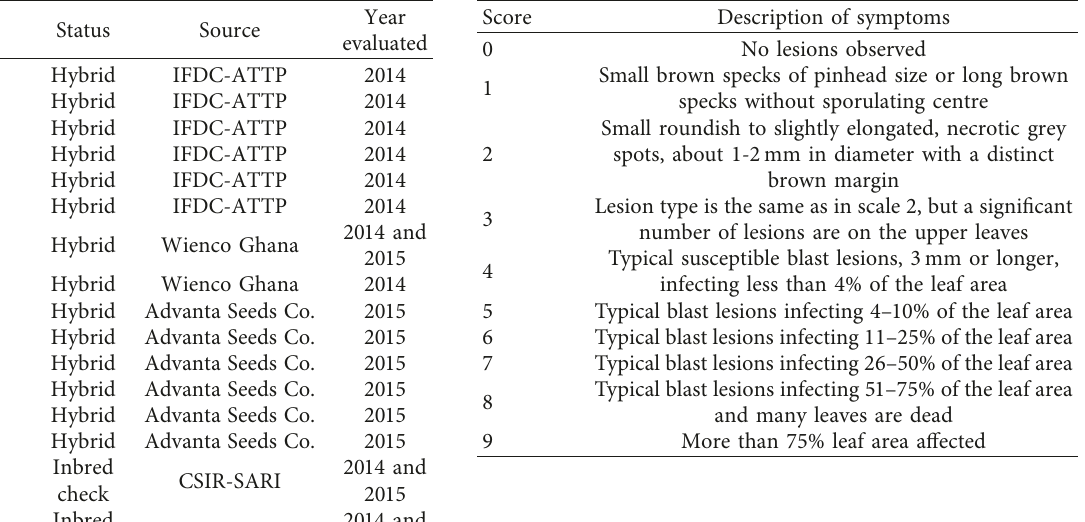
Table 3: Descriptive key for recording BLB severity.